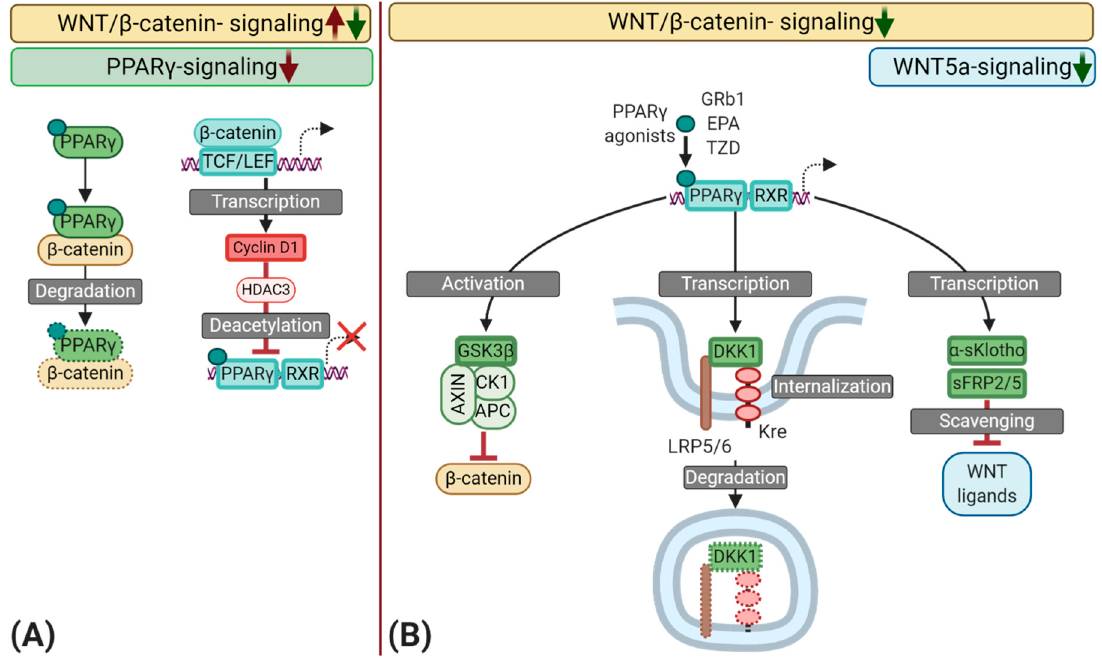
Figure 3. Schematic representation of the interplay between peroxisome proliferator-activated receptor γ (PPAR γ ) and the Wingless and Int-1 (WNT) signaling pathways during vascular calcification (VC) with a focus on the osteochondrogenic transition of synthetic vascular smooth muscle cells (VSMC). ( A ) Several mechanisms may inhibit PPAR γ signaling during atherogenesis. First, ligand-bound PPAR γ may sequester β -catenin, leading to the proteasomal degradation of this complex. As a result, a high activation of the WNT / β -catenin pathway could reduce PPAR γ availability and vice versa. Second, WNT / β -catenin signaling induces the transcription of Cyclin D1, which promotes the recruitment of Histone deacetylase 3 (HDAC3) to PPAR γ , inducing deacetylation, consequently, reducing the transcriptional activity of PPAR γ . ( B ) Various naturally occurring compounds such as polyunsaturated fatty acids like eicosapentaenoic acid (EPA) and the ginsenoside Rb1 (GRb1), as well as synthetic compounds like Thiazolidines (TZD), can directly activate PPAR γ . Upon activation, PPAR γ interacts with retinoid-x-receptors (RXR) to induce the transcription of target genes. PPAR γ may dimmish WNT / β -catenin signaling through the activation of glycogen synthase kinase-three- β (GSK3 β )—an essential part of the β -catenin destruction complex. Moreover, PPAR γ induces the transcription of WNT scavengers like secreted frizzled-related protein 2 and 5 (sFRP2 / 5), as well as secreted α -Klotho ( α -sKlotho), which results in an inhibition of SOX9 and RUNX2 by scavenging WNT ligands such as WNT5a and WNT3a. The binding of dickkopf-1 (DKK1), another transcriptional target of PPAR γ , to lipoprotein receptor-related protein 5 or 6 (LRP5 / 6) leads to a complex formation with the Kremen receptor (Kre), followed by its internalization and degradation, ultimately inhibiting Wnt / β -catenin signal transduction.